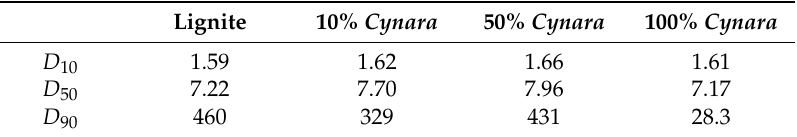
Table 4. Particle size distributions of fly ashes from test